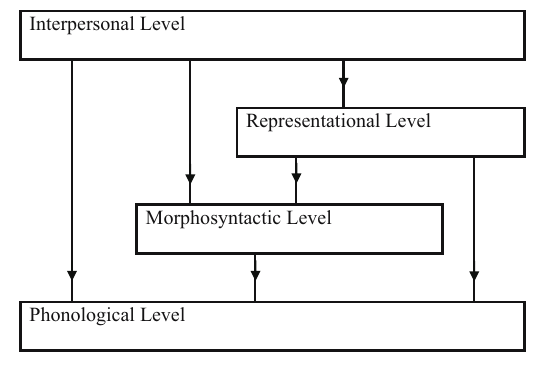
Figure 1: Levels in